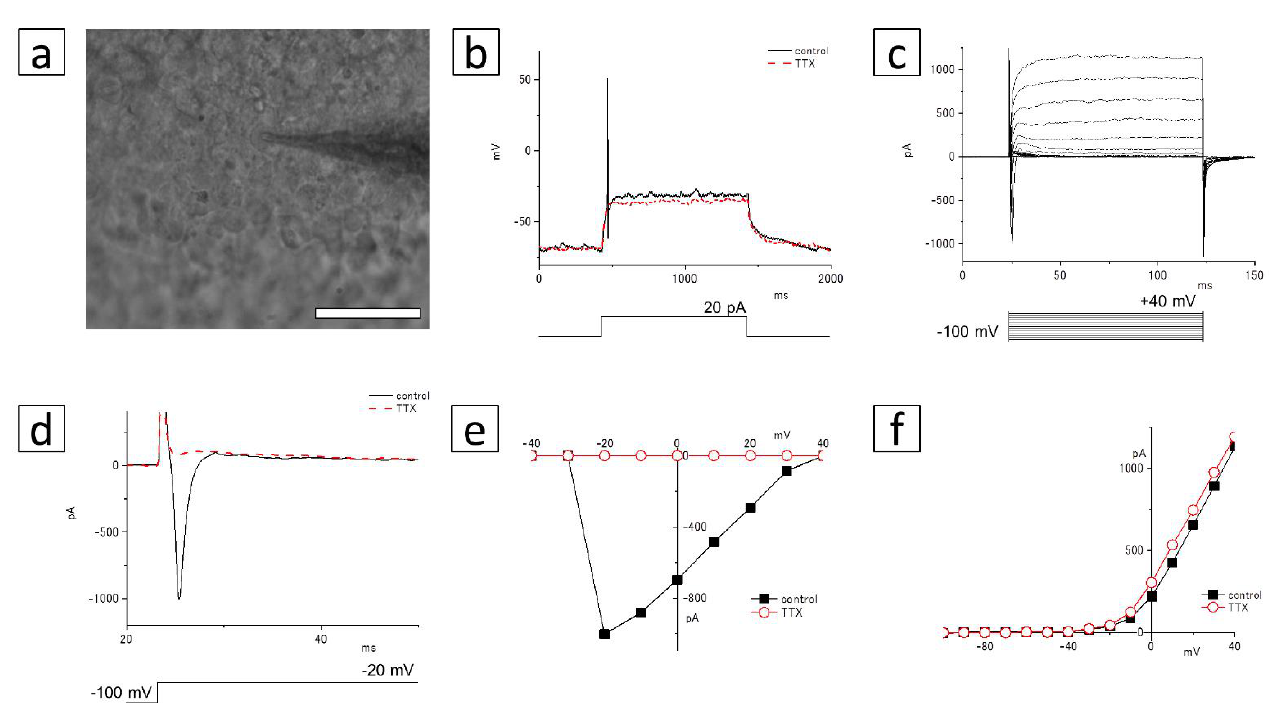
Figure 10. Patch-clamp recording of the Neurofilament-M- and Brn-3b-positive cells in the cell cluster. ( a ) A micrograph of the cultured cells. The patch electrode approaches the soma of the cell from the right side. Bar: 50 µ m. ( b ) Responses to a depolarization induced by an injection of 20 pA current, recorded in control Ringer’s solution ( thin line ), and with the addition of 1 µ M TTX ( dotted line ). ( c ) Membrane currents of the cultured cells by depolarizing voltage steps from a holding potential of –100 mV. Command voltages were increased in 10 mV steps from − 100 mV to +40 mV. ( d ) Command voltages were increased to − 20 mV in control solution ( thin line ) or 1 µ M TTX ( dotted line ). The inward current at the beginning of the voltage-step was blocked by TTX. ( e ) The I–V relationship of voltage-gated inward currents. The peak inward currents in control solution ( filled squares ) or in 1 μM TTX ( open circles ) were plotted against the test-pulse voltage. ( f ) The I–V relationship of voltage-gated outward currents. The amplitudes of outward currents in control solution ( filled squares ) or in 1 μM TTX ( open circles ) were plotted against the test-pulse voltage.